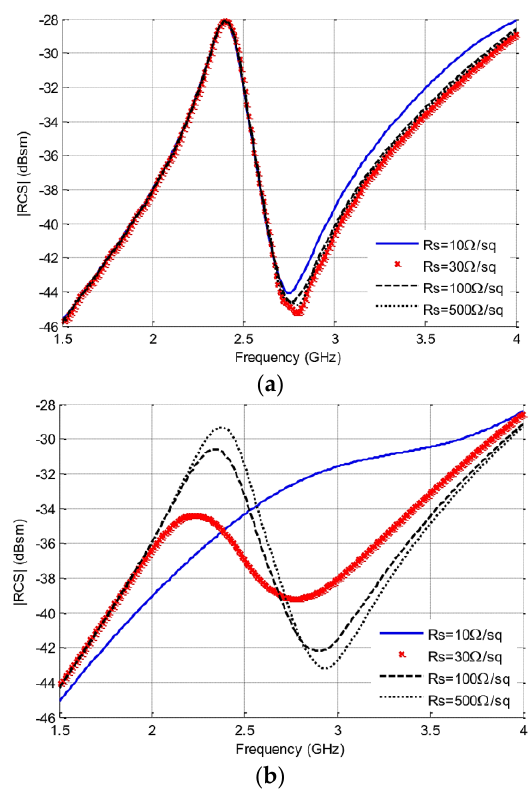
Figure 6. Simulated RCS responses as a function of the plate resistance of the SWCNT deposit for: ( a ) the vertical polarization; and ( b ) the horizontal polarization [51].